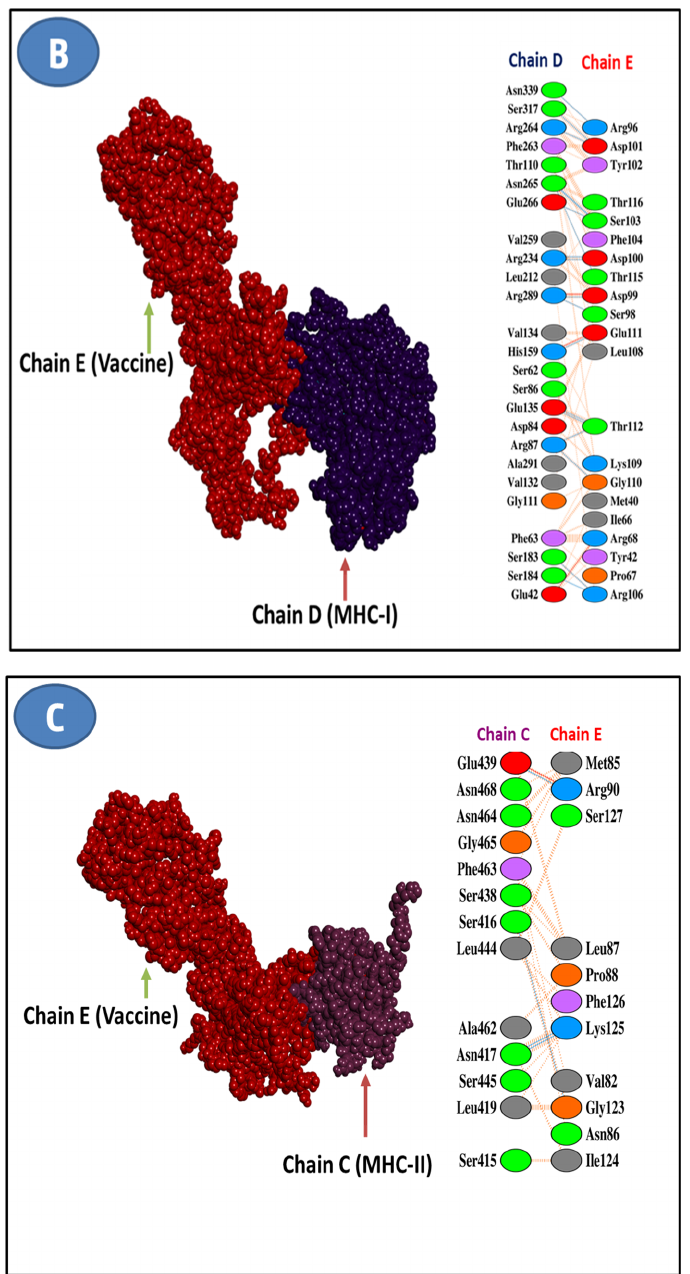
Figure 8. Analysis of vaccine–receptor binding conformation and interaction with ( A ) Vaccine–TLR4, ( B ) Vaccine–MHC I, and ( C ) Vaccine–MHC II.